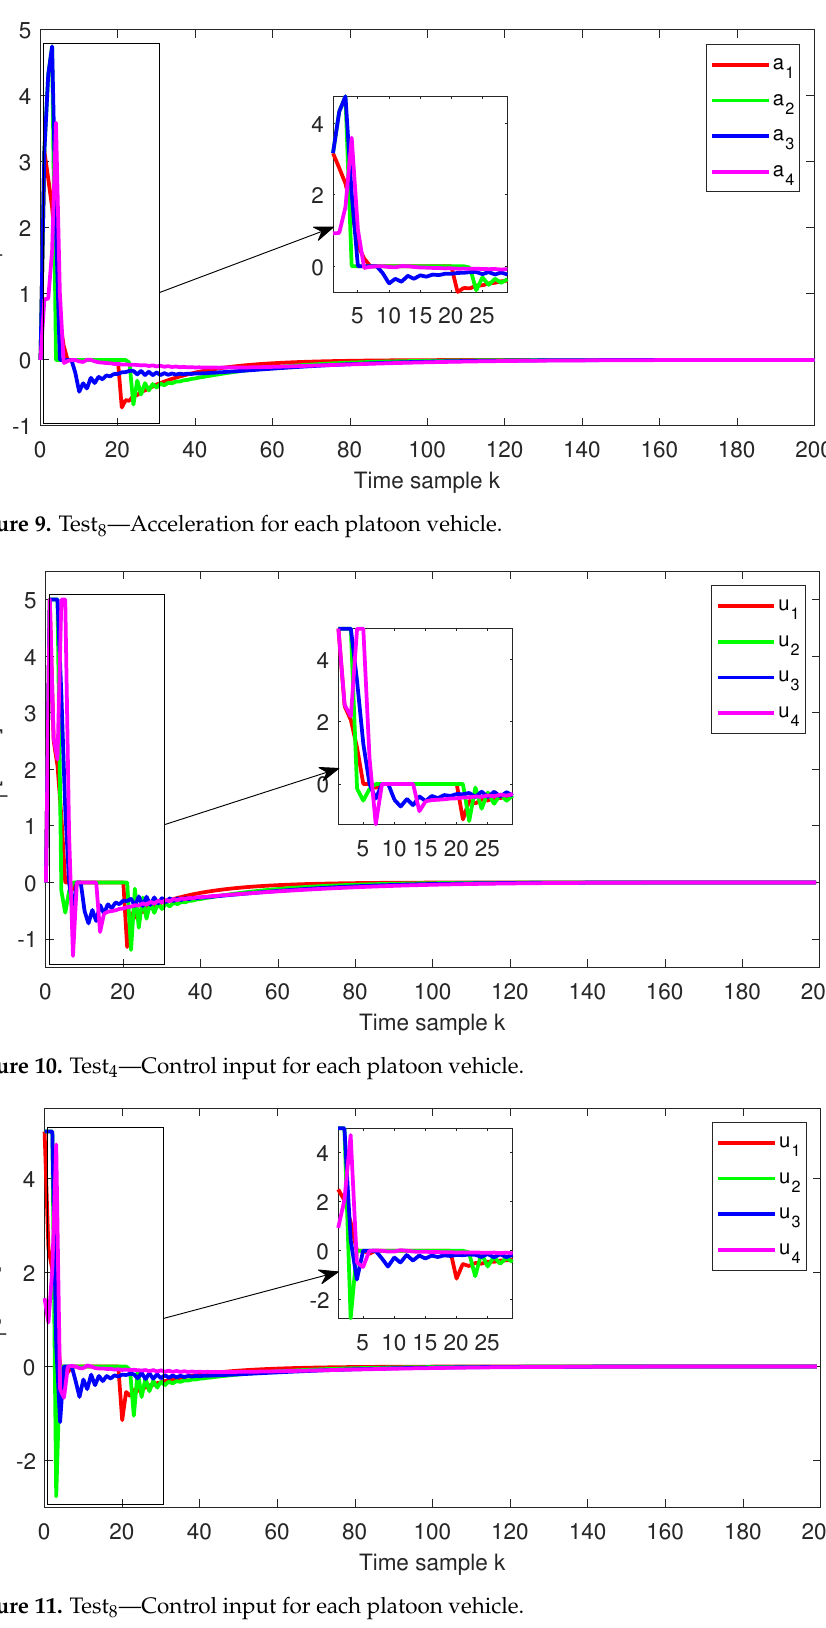
Figure 11. Test 8 —Control input for each platoon vehicle. From the C-DMPC point of view, a platoon consisting of 4 vehicles uni-directionally coupled in a leader-follower communication architecture, has eight possible communica- tion frameworks, including coalitions of 2, 3 or 4 agents defined in Table 3